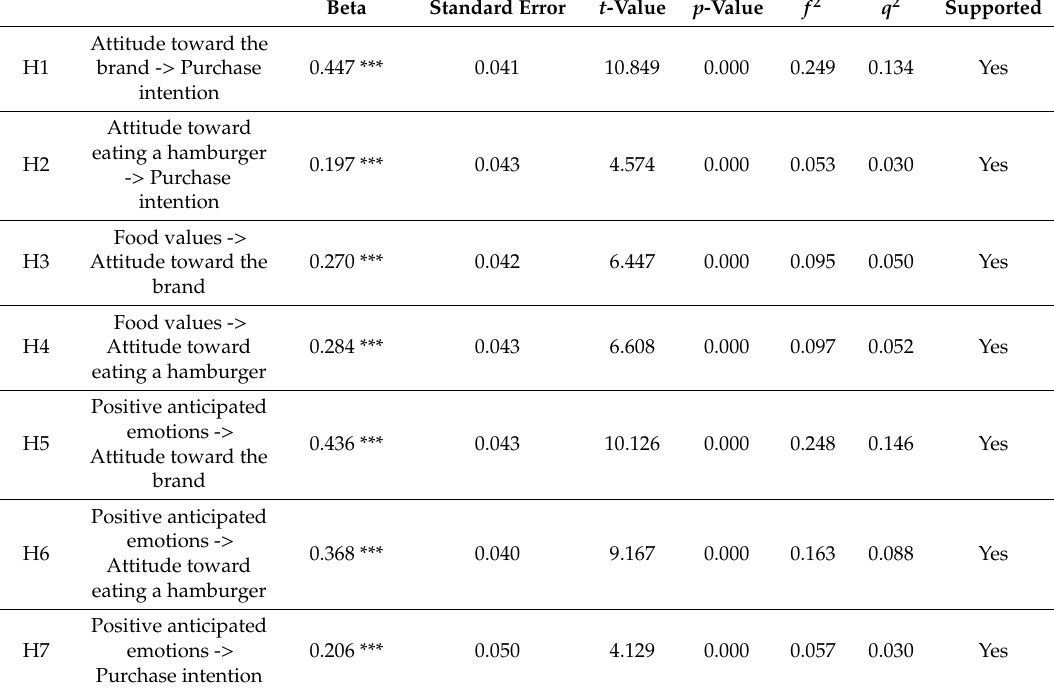
Table 5. Hypothesis Testing and Path Coe ffi